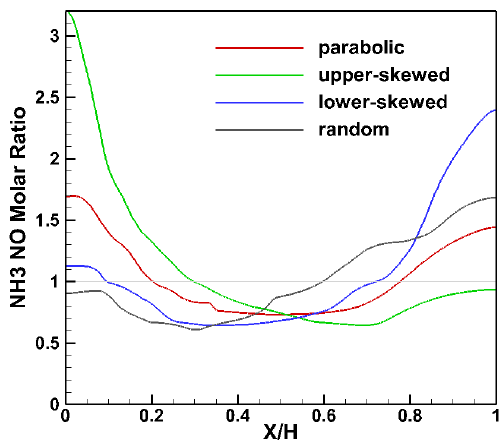
Figure 8. Spanwise variation of NH 3 /NO ratio at the inlet of the catalyst layer before AIG nozzle con- trol.